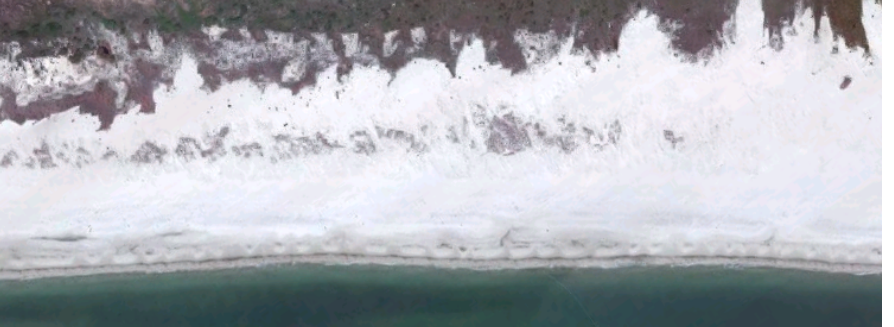
Figure 3. Florida Beach (Image Source: Google Maps).